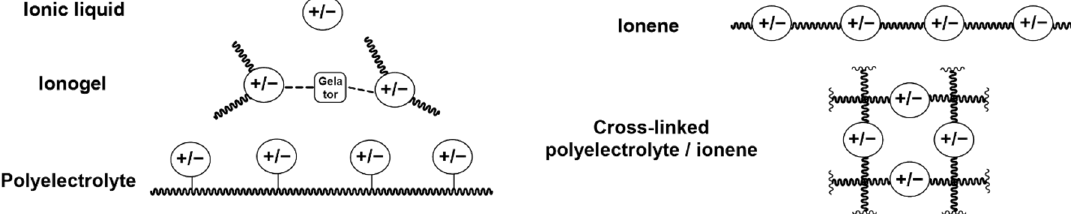
Figure 1. Schematic representation of different poly(ionic liquid) (PIL) structures and terminology thereof.